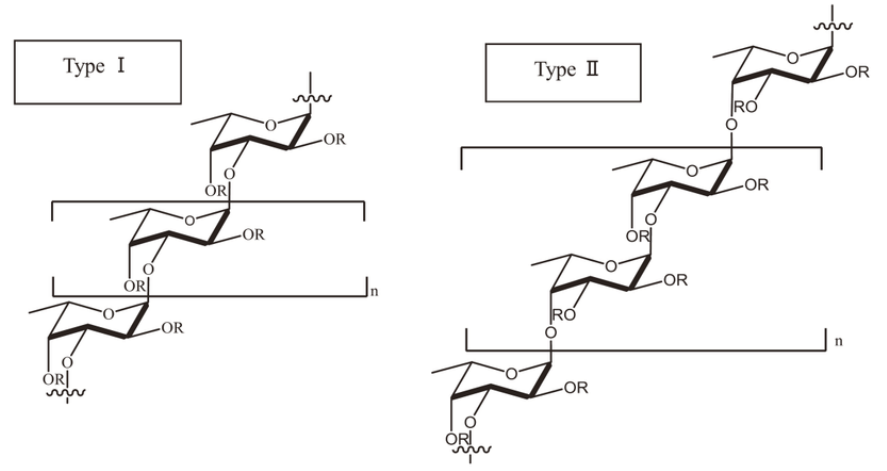
Figure 1. Structure of fucoidan. Type I fucoidan has repeating units of α‐ (1 → 3) ‐ linked α‐ L ‐ fucopyranose and Type II fucoidan has alternately repeating units of α‐ (1 → 3) ‐ and α‐ (1 → 4) ‐ linked α‐ L ‐ fucopyranose [31].